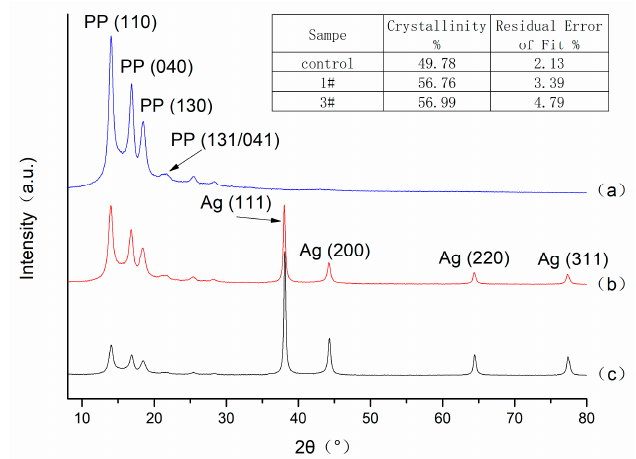
Figure 2. X-ray diffractometer (XRD) patterns of ( a ) nonwoven polypropylene, ( b ) Ag coated nonwoven polypropylene (1#), and ( c ) Ag coated nonwoven polypropylene (3#).